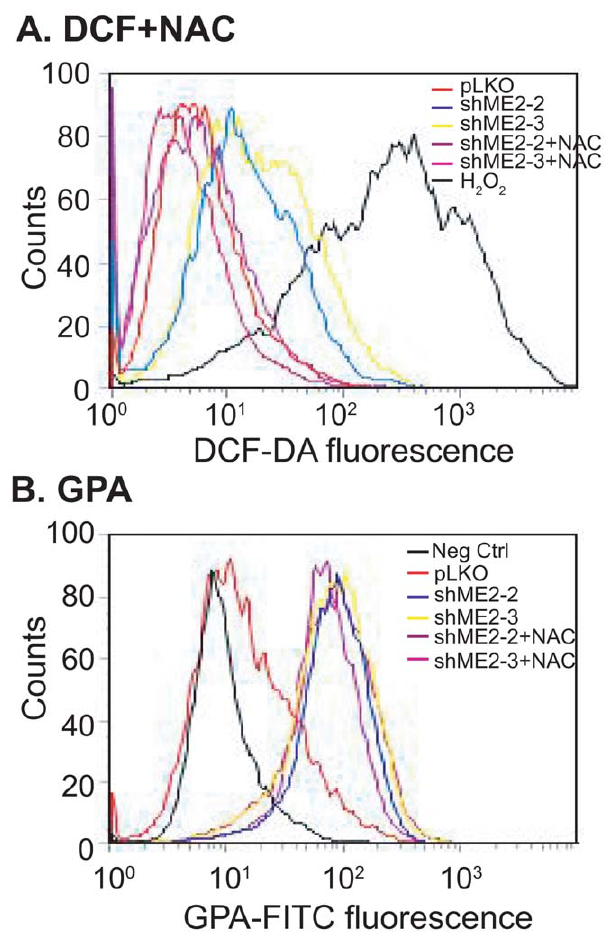
Figure 5. The antioxidant NAC cannot rescue ME2 knockdown induced erythroid differentiation in K562 cells. A: 5 mM NAC completely rescues ROS generation in K562 cells as detected by flow cytometry using CM-H 2 DCF-DA. Each histogram is representative of three experiments. B: ROS inhibition by 5.0 mM NAC did not rescue ME2 knockdown induced erythroid differentiation in K562 cells. Each histogram is representative of three experiments.